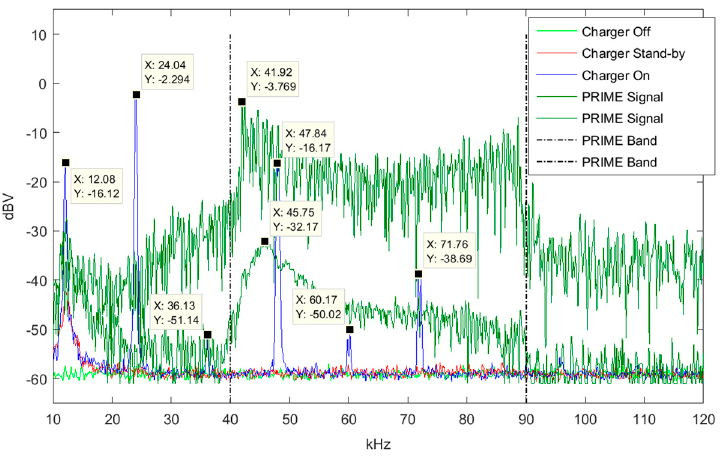
Figure 8. Spectrum recorded at the battery charger SM with the rest of devices disconnected.